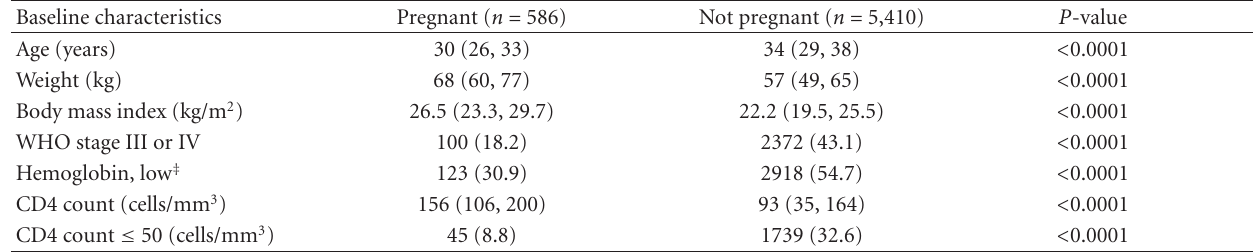
Table 1: Characteristics of 5,996 women initiating HAART in Johannesburg, South Africa from 1 April 2004 to 30 September 2009 by pregnancy status at baseline.